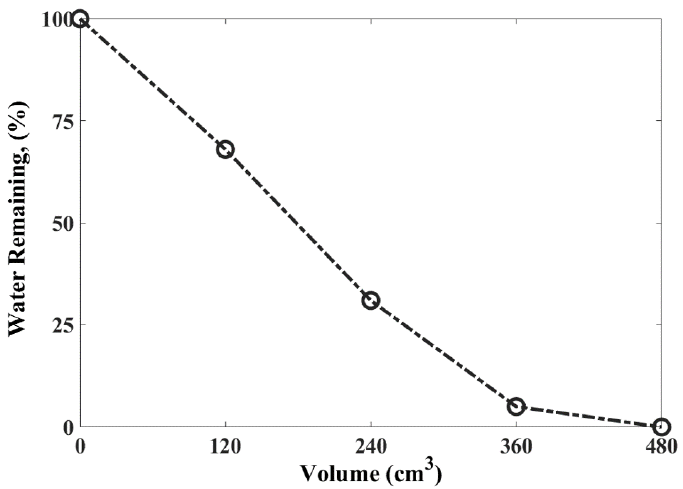
Figure 7. Calculated results for the implementation of stepwise drying simulation technique on 100 cm 3 of water at 1200 W power.